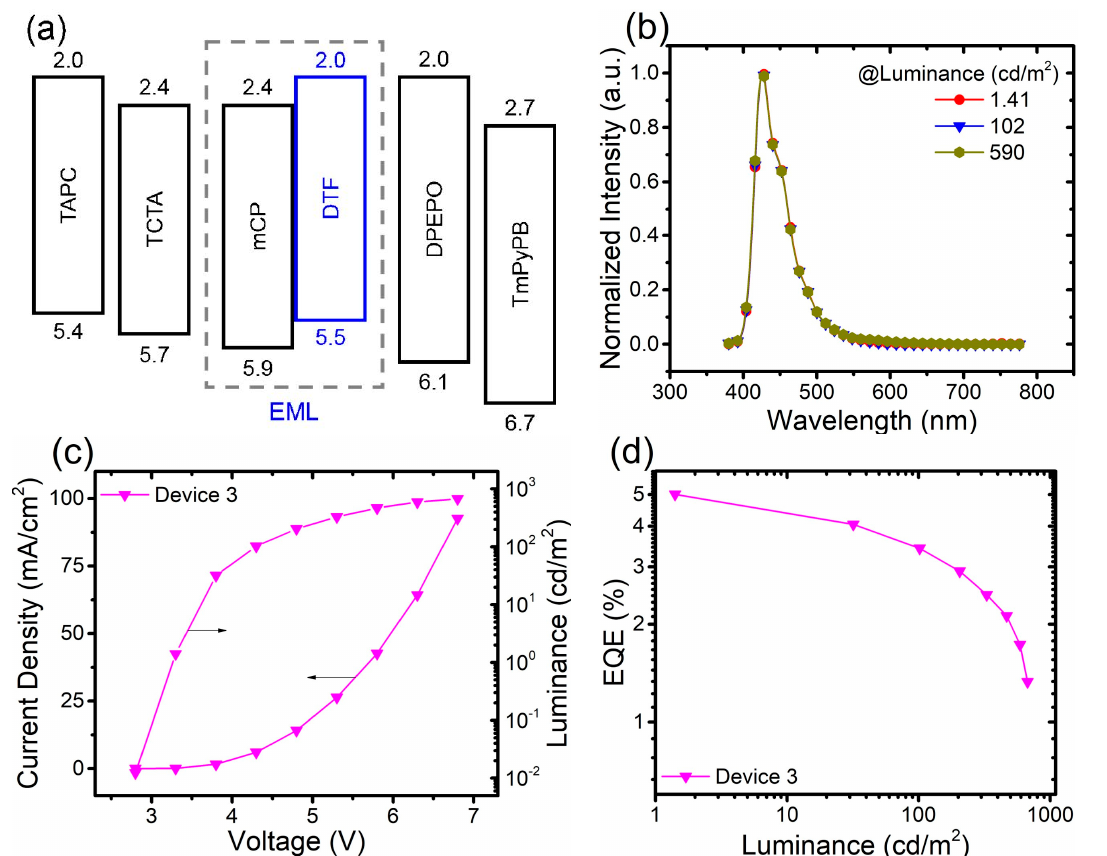
Figure 6. Device 3: ( a ) Structure and HOMO, LUMO energy levels (in eV); ( b ) EL spectra with dif- ferent luminance; ( c ) J-V-L plots; and ( d ) EQE curve. different luminance; ( c ) J-V-L plots; and ( d ) EQE